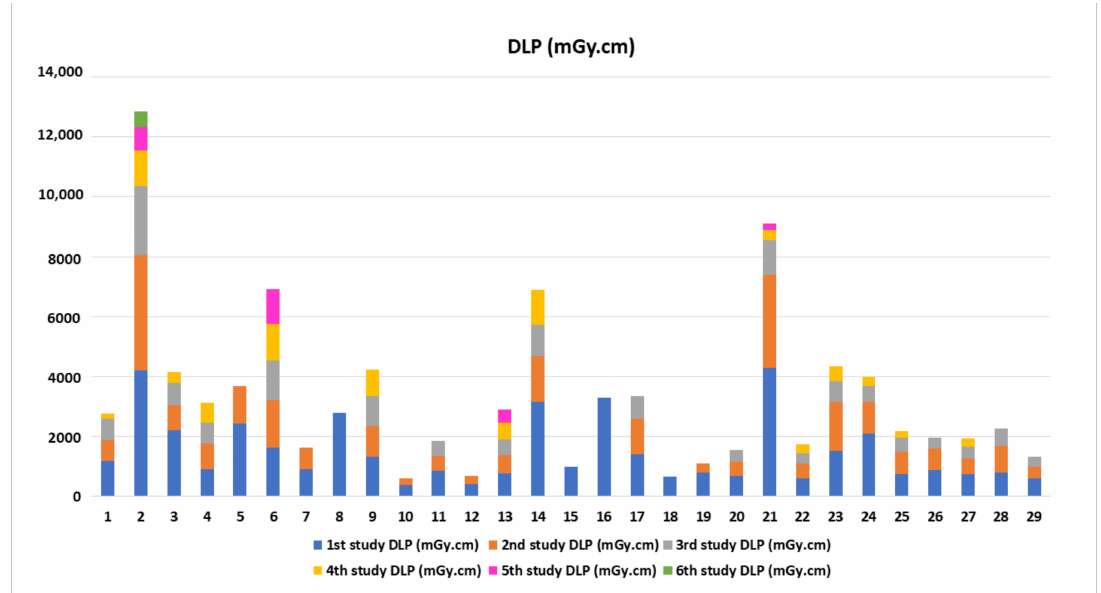
Figure 3. The cumulative dose length product (DLP) of each individual.